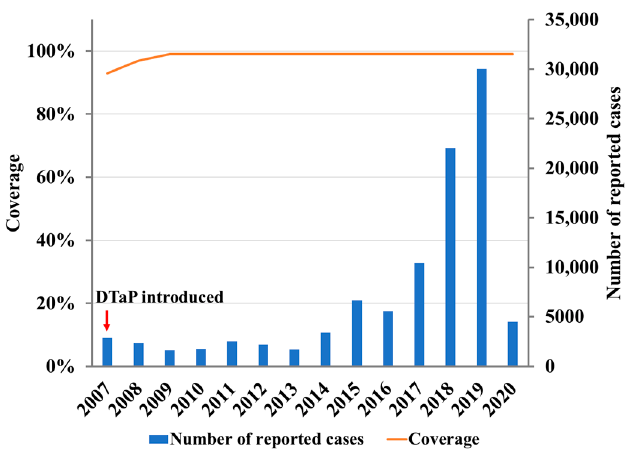
Figure 1. DTP3 vaccination coverage and number of reported pertussis cases in China, 2007–2020 [10,11]. Adapted with permission from Ref. [10]. 2022. Geneva: World Health Organization (WHO). Licence: CC BY-NC-SA 3.0 IGO. DTP3: diphtheria tetanus toxoid and pertussis (DTP)-containing vaccine, 3rd dose.